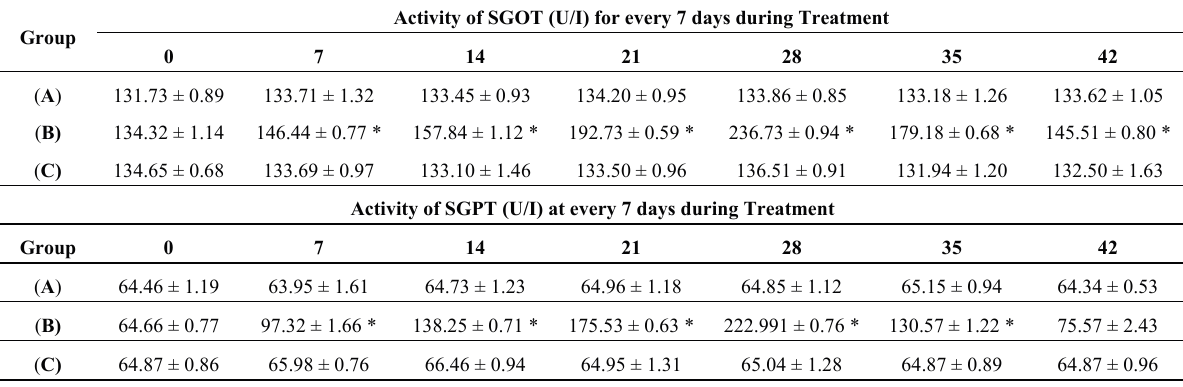
Table 2. The SGOT and SGPT Activities of rat plasma during treatment on groups of non-cholesterol ( A ); cholesterol ( B ); and EMD 0.5 g/kgbw ( C ). Activity of SGOT (U/I) for every 7 days during Group